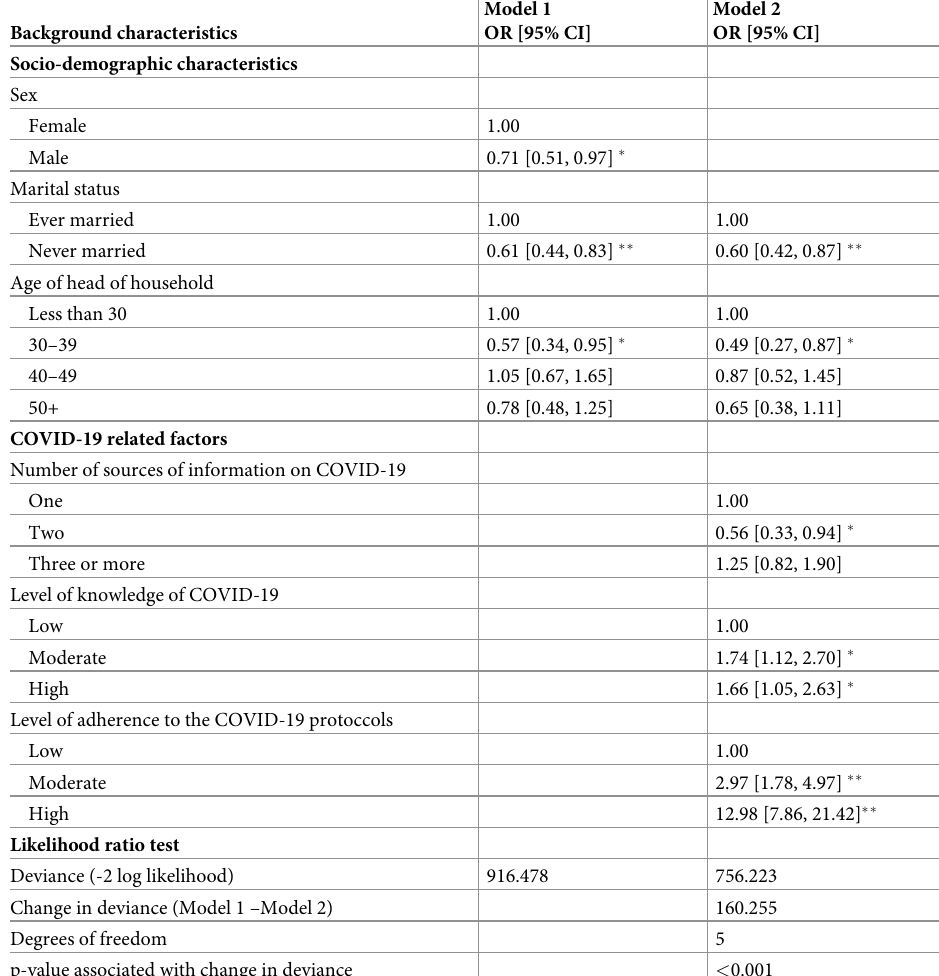
Table 5. Factors associated with the severe psychological impact of the COVID-19